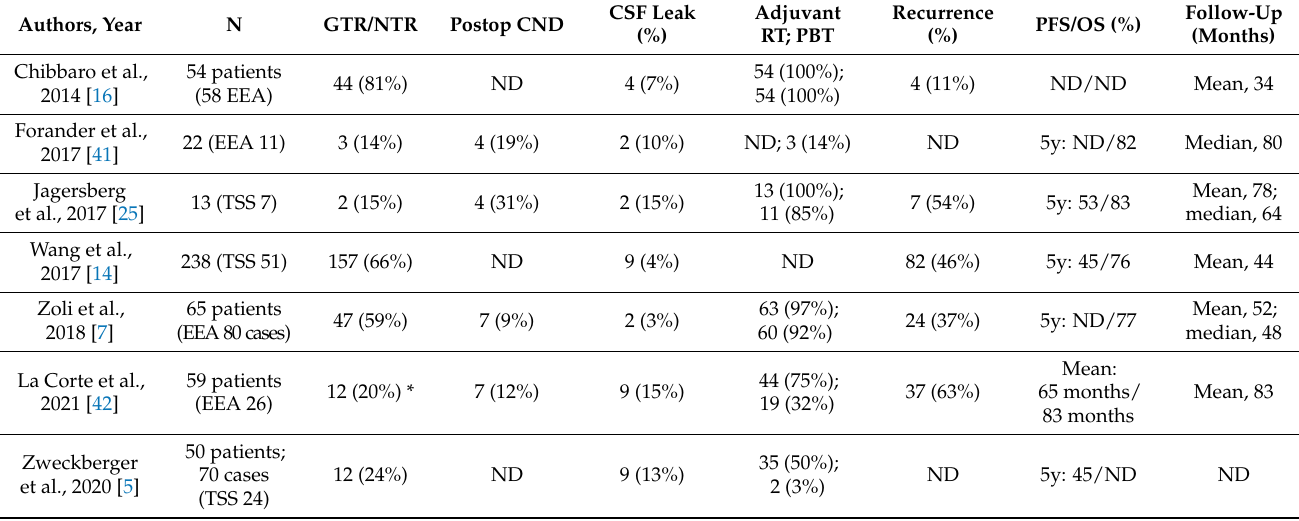
Table 7. Comparison with past literature. PFS and OS are comparable to other